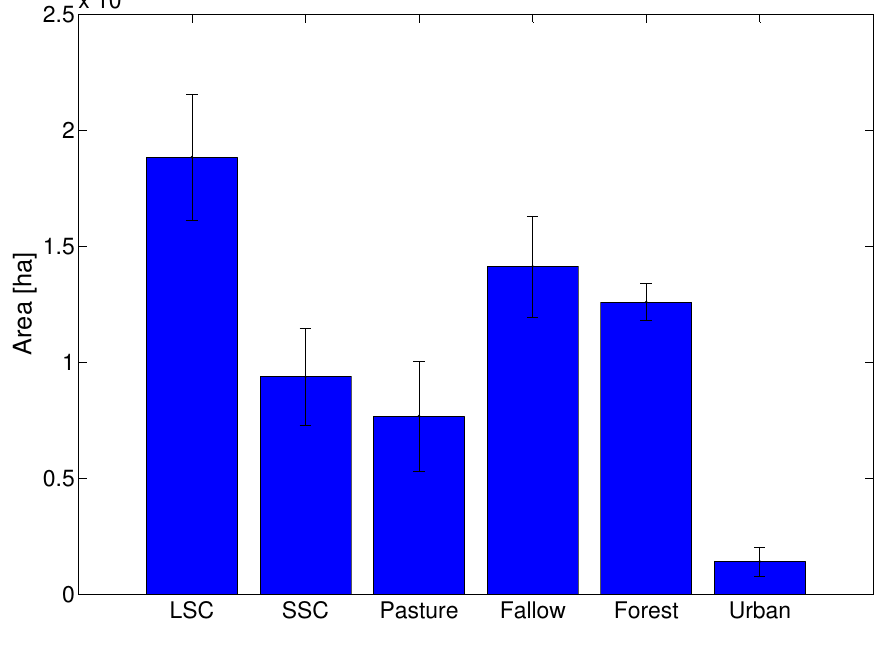
Figure 6. Error-adjusted area estimates of the hierarchical classification with 95% confidence intervals (LSC = large-scale cropland, SSC = small-scale cropland).